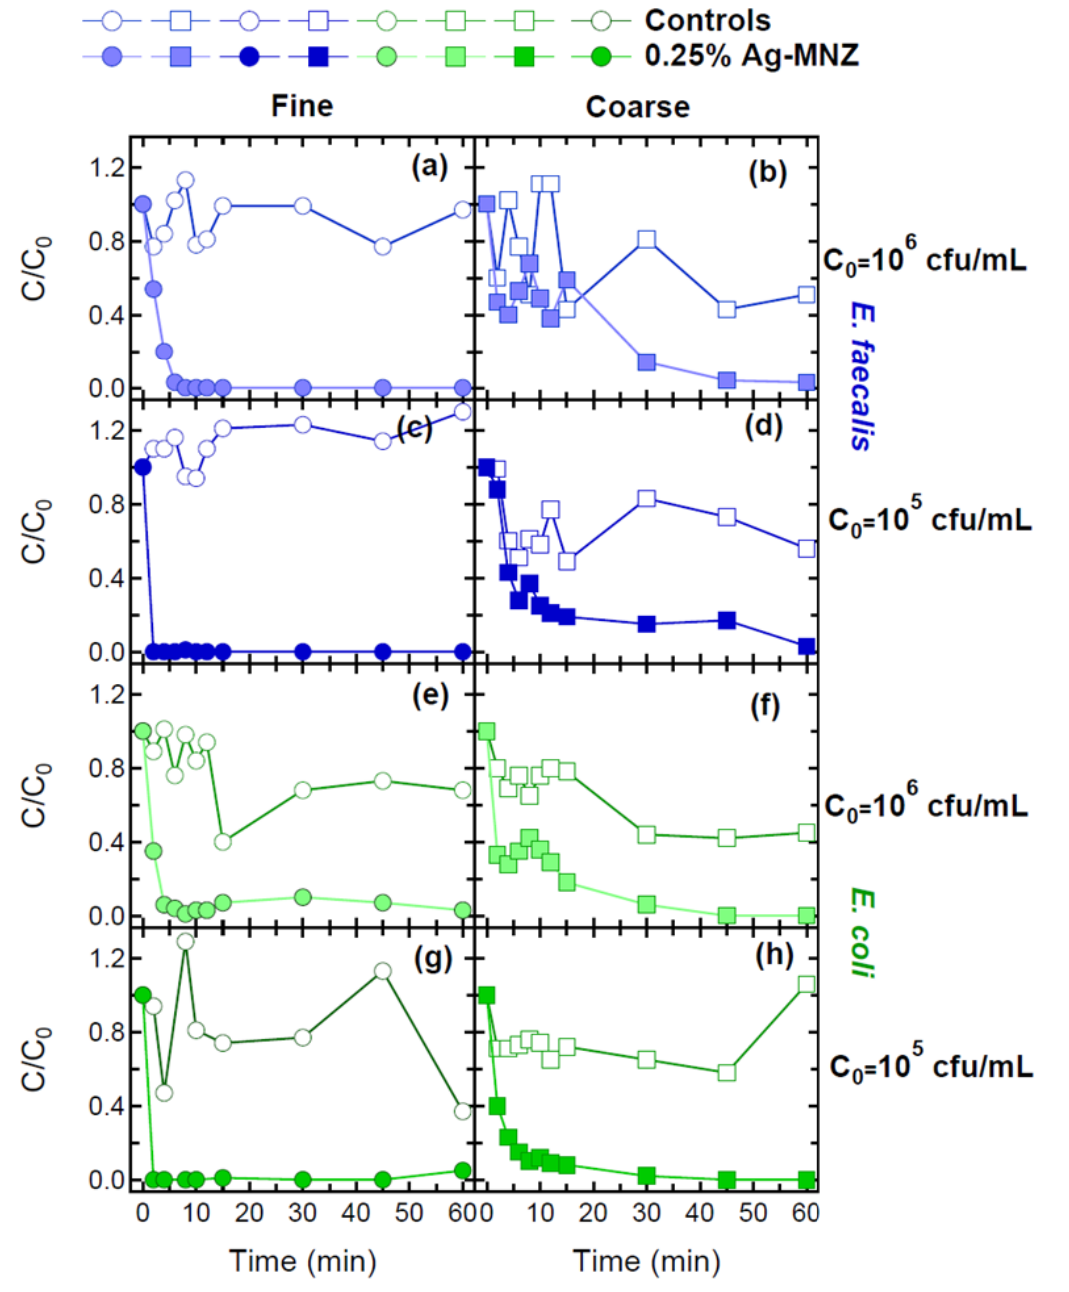
Figure 5. Experimental inactivation data of E. faecalis ( a – d ) and E. coli ( e – h ) removal by fine (0–1 mm) Ag-MNZ ( a – g ) and coarse (1–3 mm) Ag-MNZ ( b – h ) in the absence (empty symbols) and the presence (filled symbols) of zeolites. Bacterial initial concentrations: 10 6 and 10 5 cfu/mL.